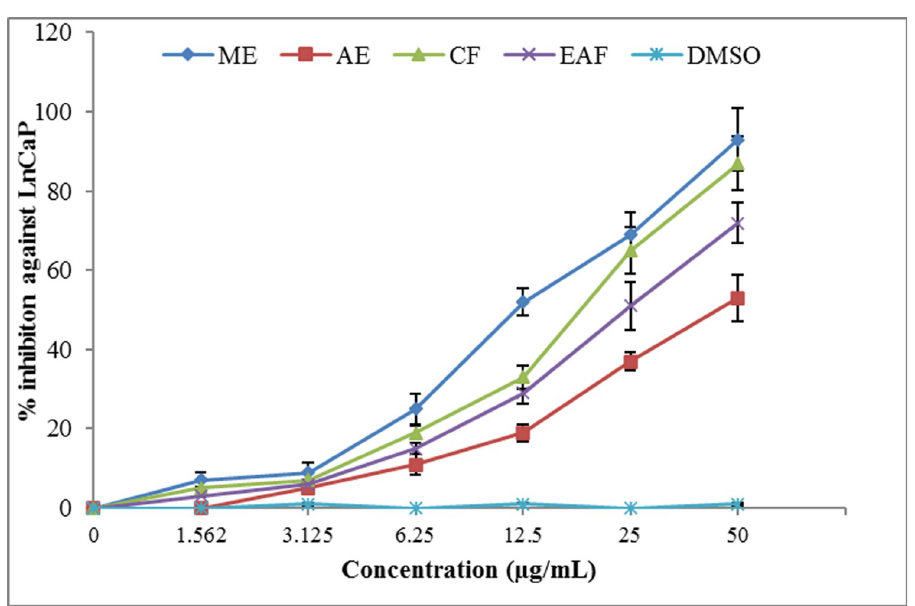
Fig 5. Analysis of cytotoxic activity of J . mimosifolia extracts and fractions against growth of hormone-dependent prostrate carcinoma (LnCaP-1) cells. Data represent mean ± standard deviation (SD) of three biological replicates.